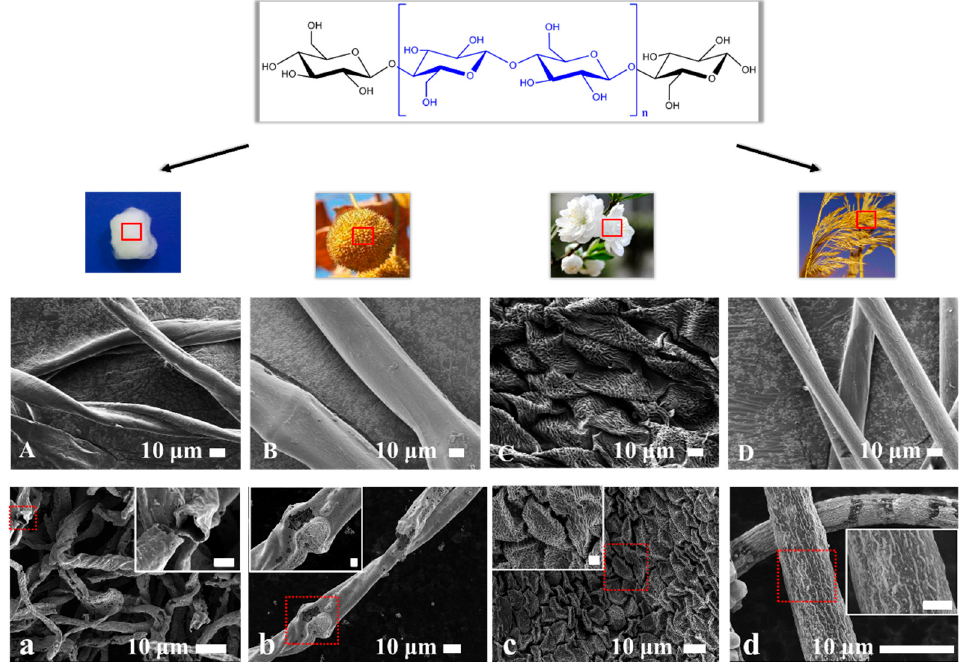
Figure 2. Silver fabricated from different cellulose-based biomass templates: ( A , a ) medical absorbent cotton, ( B , b ) seed balls of oriental plane, ( C , c ) petals of peach blossom, and ( D , d ) catkins of reed. The above shows the molecular structure of the cellulose and digital photographs of the cellulose-based templates. SEM images of ( A , B , C , D ) original biomass templates and ( a , b , c , d ) silver fabricated from the templates. The insets in the last row are enlarged SEM images of the red square, and all the scale bars are 2 μ m.